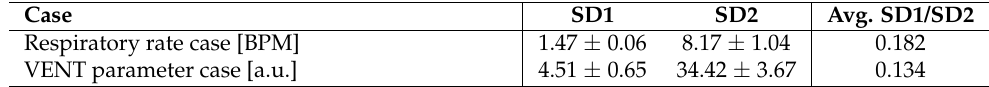
Table 2. The statistics of respiratory-related Poincare-plot equivalent characteristics described by SD1, short-term variability, SD2, long-term variability, and their ratio, for analyses performed for respiratory rate and VENT parameter cases; BPM stands for breaths per